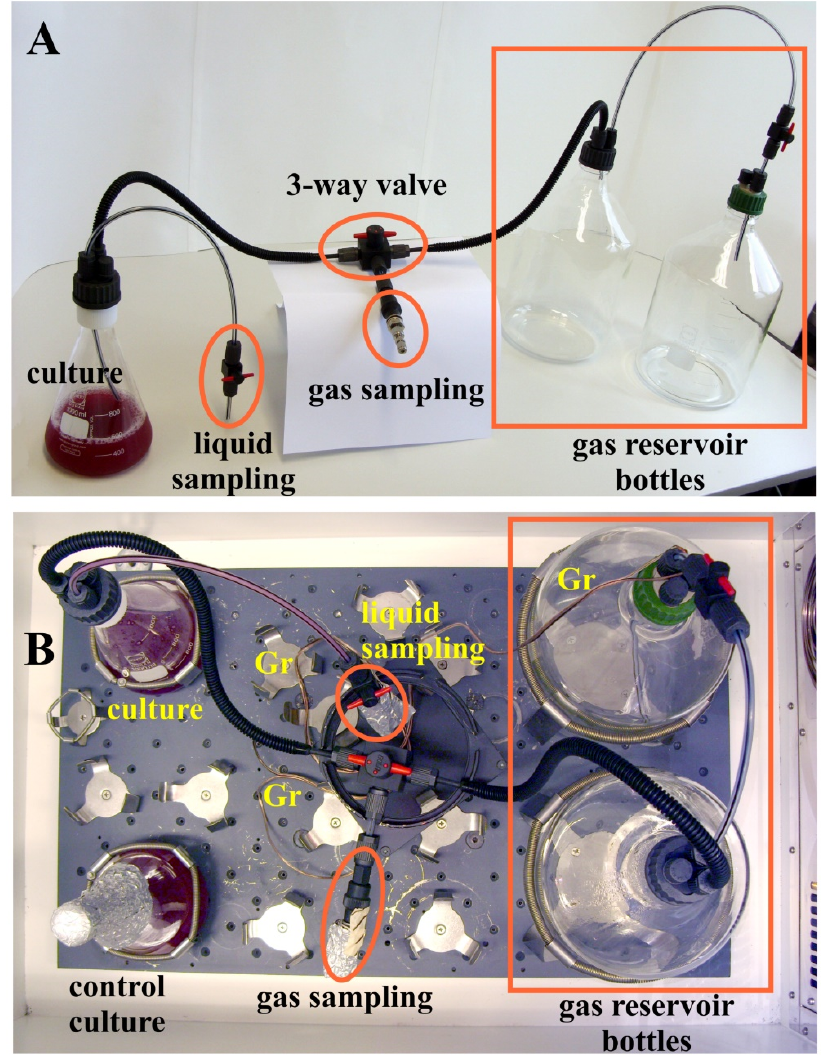
Figure 4. ( A ) The experimental setup for semi-aerobic incubation of R. rubrum using gas-tight and explosion-proof tubing and connections. ( B ) shows the positions of the bottles and flasks in the shaker during the growth experiment. The copper wire (Gr) used for grounding is also visible. The control culture (bottom left) is also shown. The growth experiment was performed in the dark (in a closed, light-tight shaker) at 30 °C.